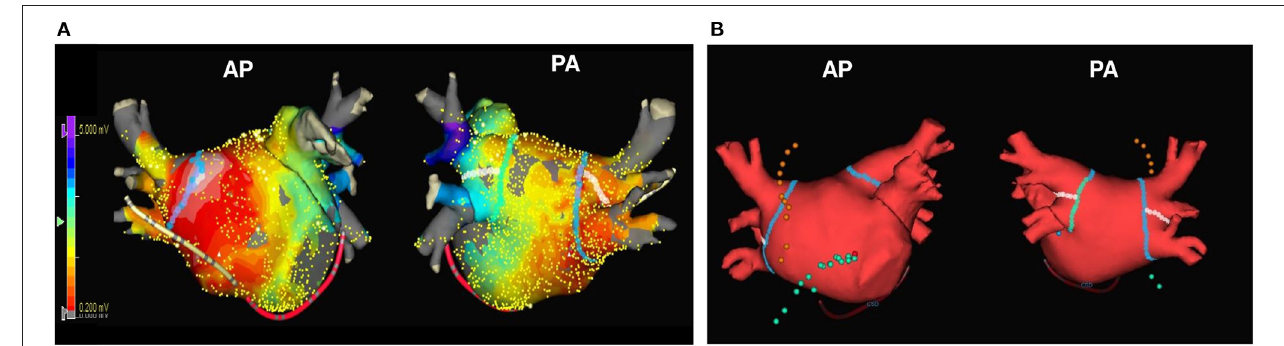
FIGURE 1 | The representative images of the LA voltage map and usual ablation lesion set. The representative images of LA voltage map (A) and usual ablation lesion set that include CPVI, SVC-right septal line, and CTI line (B) . CPVI, circumferential pulmonary vein isolation; CTI, cavo-tricuspid isthmus; LA, left atrium; SVC, superior vena